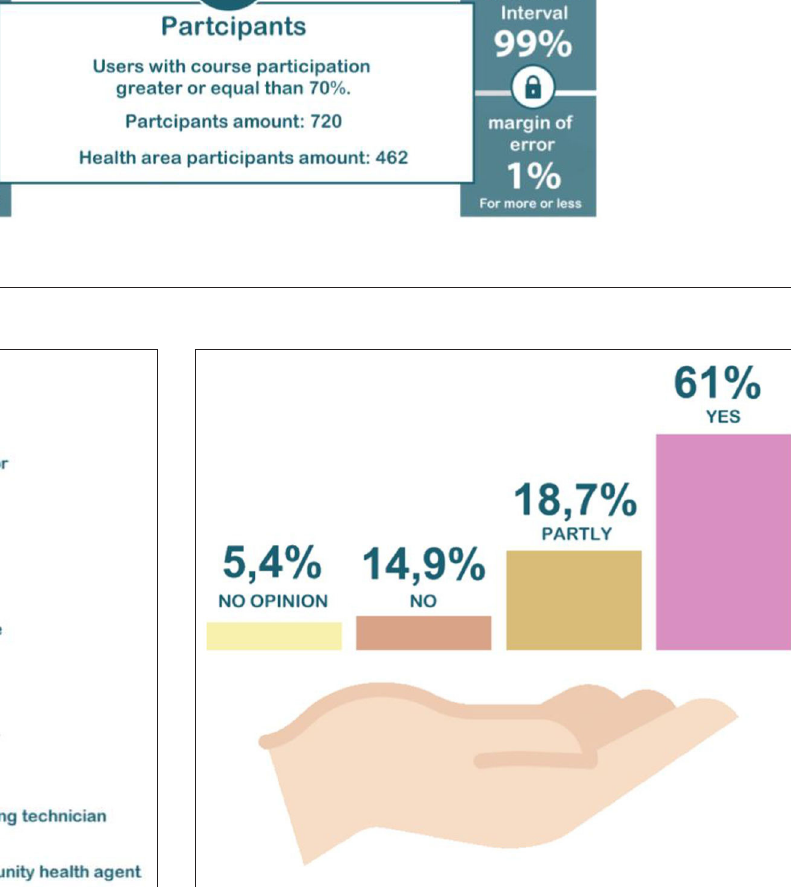
FIGURE 3 | Participants by Federation Unit